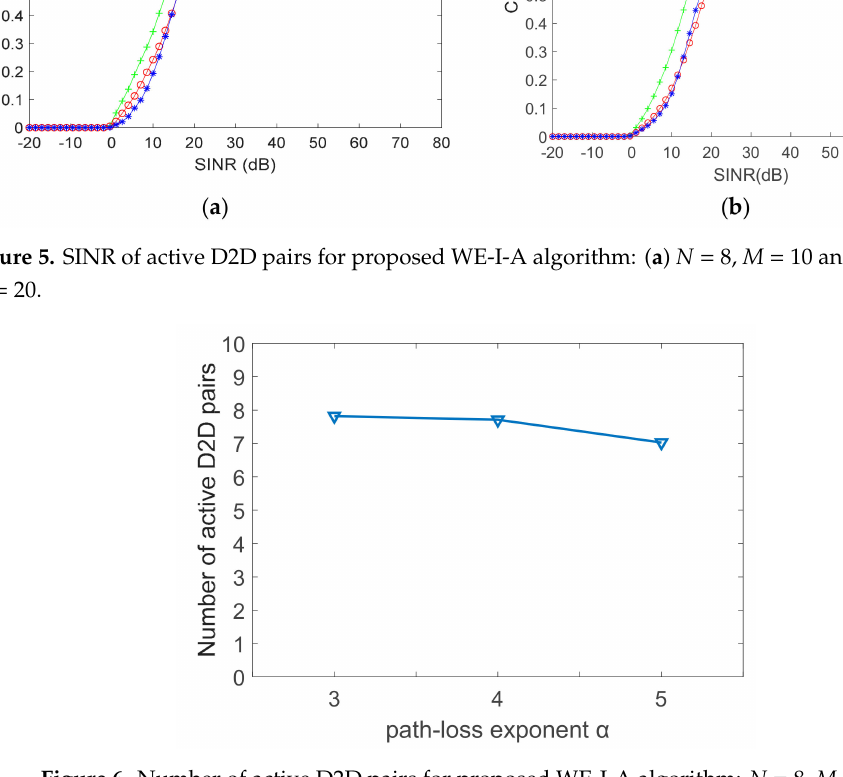
Figure 6. Number of active D2D pairs for proposed WE-I-A algorithm: N = 8, M =